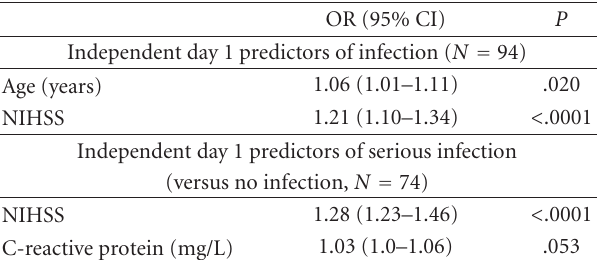
Table 4: Significant associations of day 5 markers of infection with serious